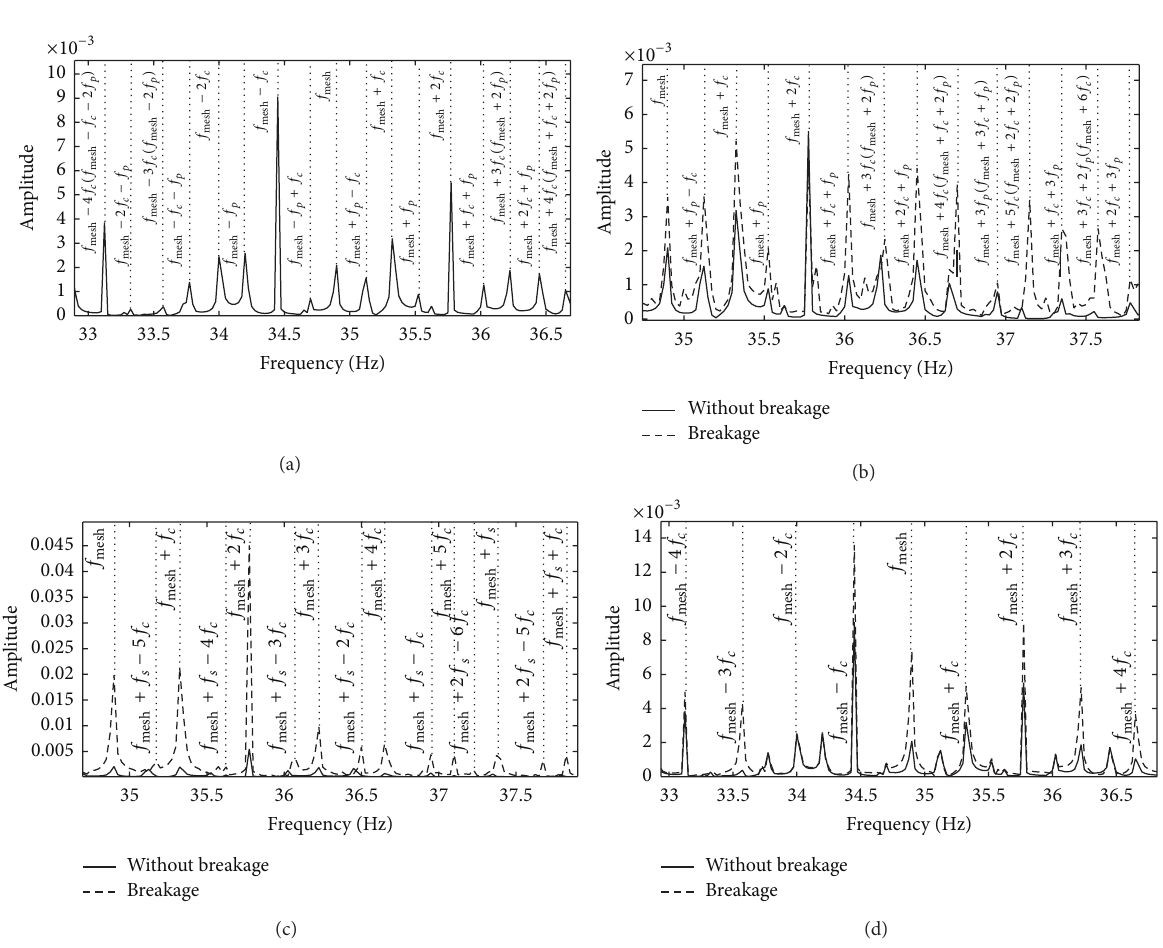
), (d) ring gear with and without mesh